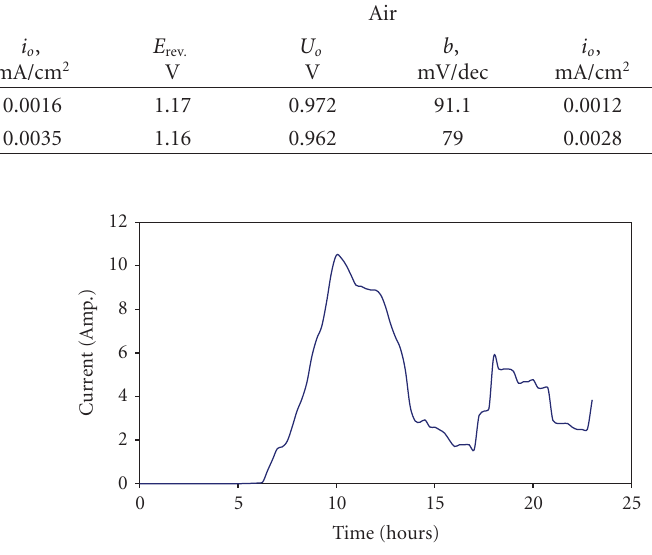
Figure 7: Measured fuel cell and electrolyzer mode bus available current.